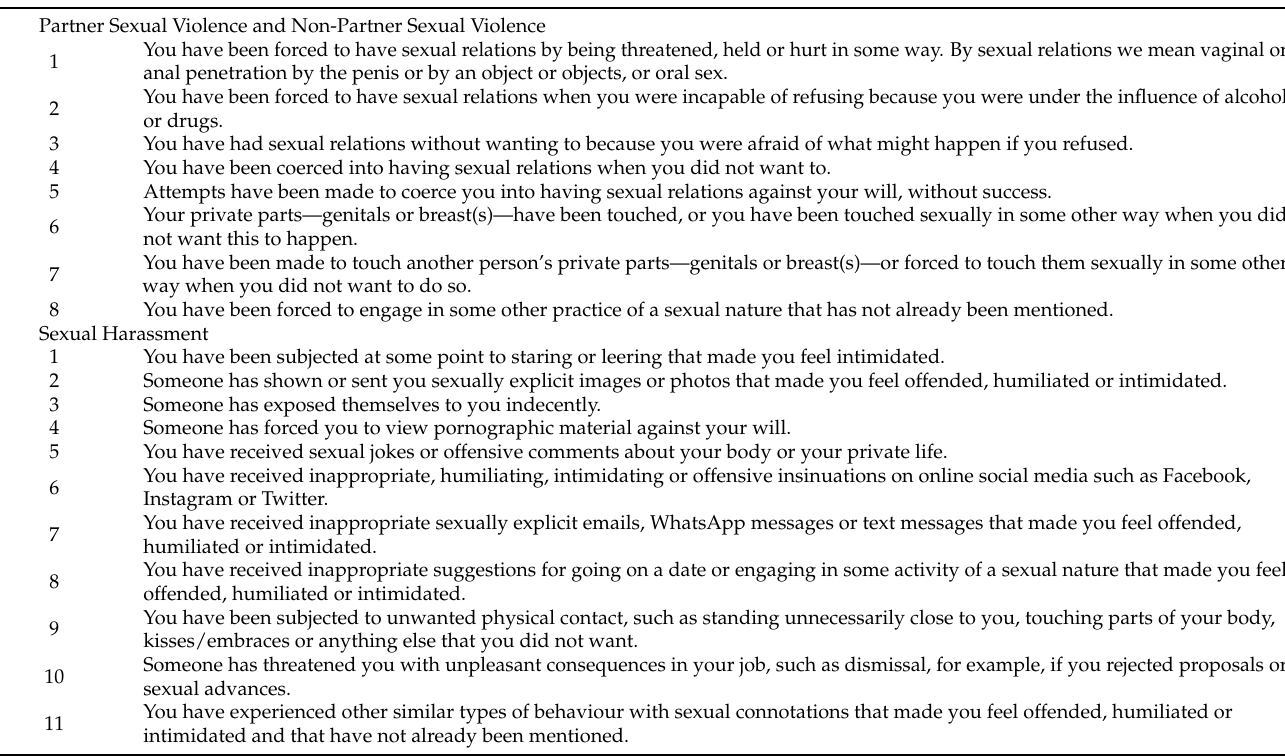
Table A1. Forms of sexual violence included in the